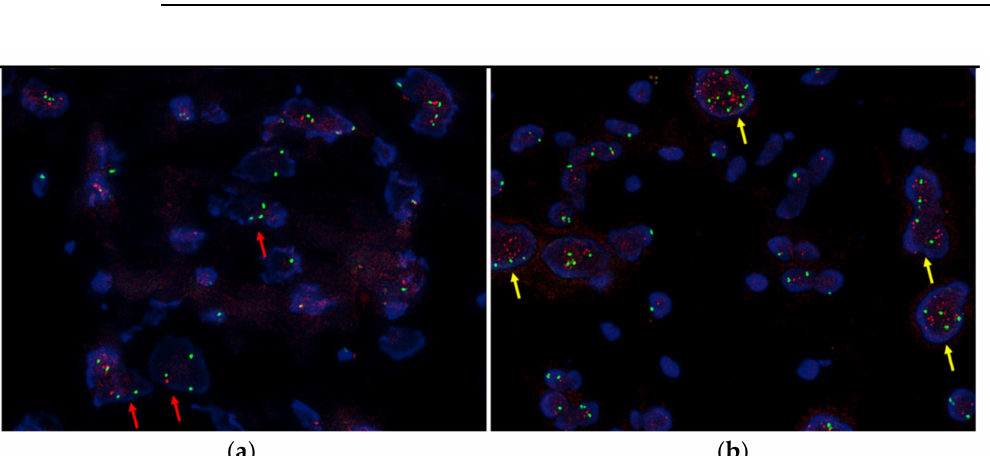
Figure 2. FISH detecting a few tumor cells with definite chromosomal alteration. ( a ) 11q deletion (red arrows). ( b ) 17q gain (yellow